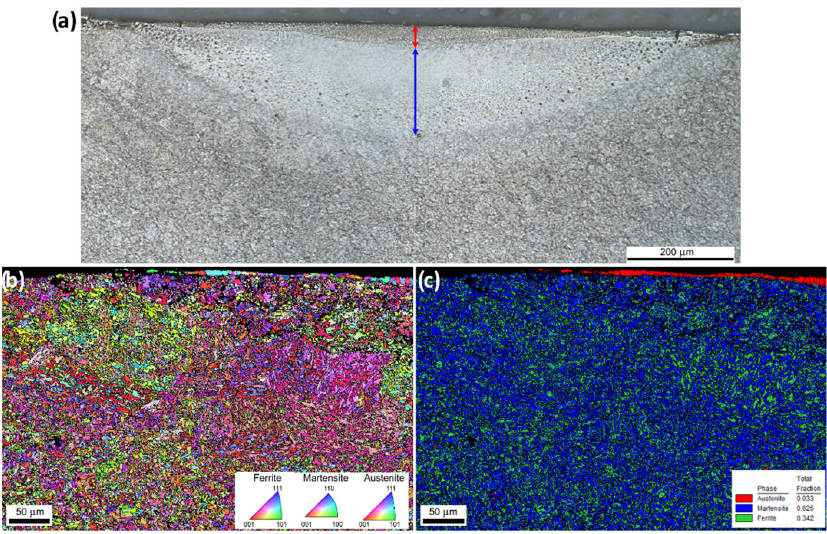
Figure 13. ( a ) optical micrograph after etching of the cross-section of a single line made with the laser parameter of Optim 9. ( b ) EBSD inverse pole figure (IPF) map in color-coded as well as the grain boundaries in black of the same cross-section. ( c ) EBSD phase map (color coded).